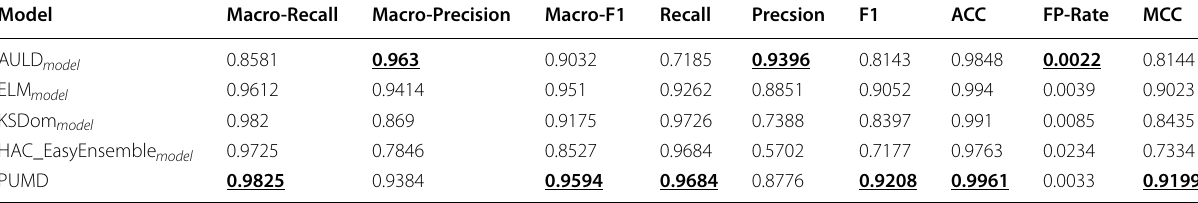
Underlined value : overall best performance